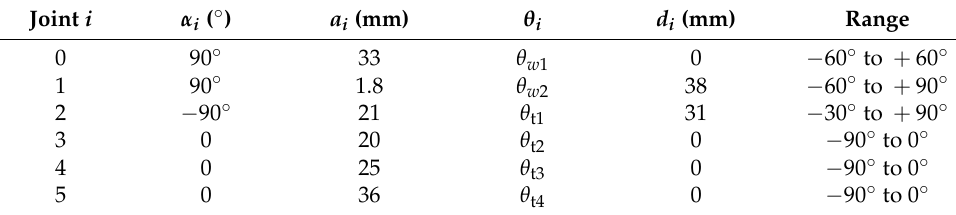
Table 2. D–H table of the